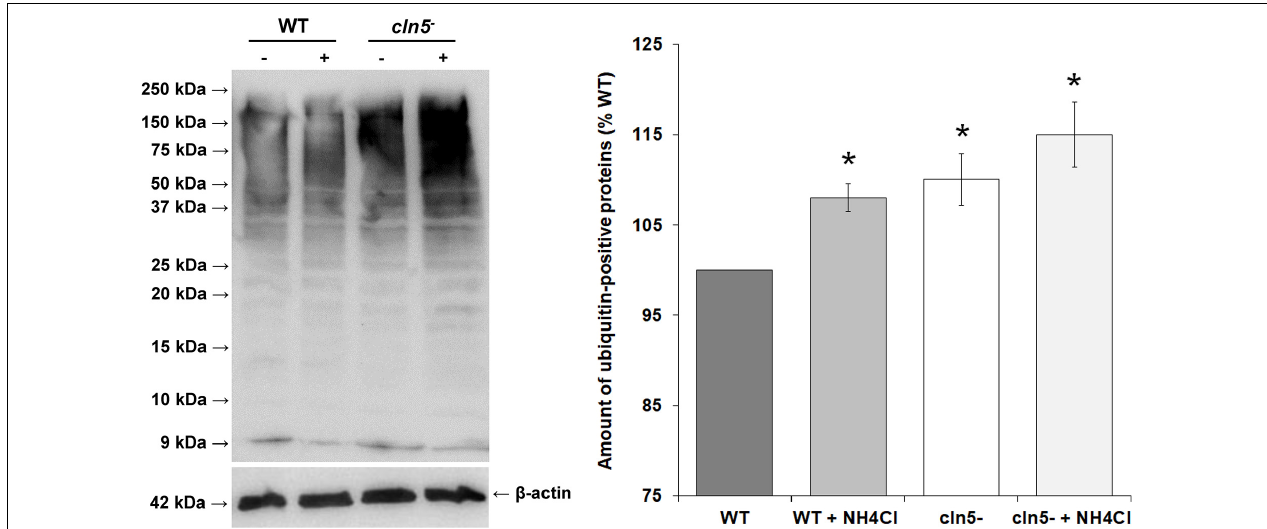
FIGURE 5 | Effect of cln5 -deficiency on the amounts of ubiquitin-positive proteins. WT and cln5 − cells were submerged in HL5 ± ammonium chloride (100 mM) for 2 h. Whole cell lysates (25 µ g) were separated by SDS-PAGE and analyzed by western blotting with anti-ubiquitin and anti-beta-actin (loading control). Molecular weight markers (in kDa) are shown to the left of the blot. The amounts of ubiquitin-positive proteins were quantified, normalized to beta-actin, and plotted. Raw values were then expressed as a percentage of the amounts of ubiquitin-positive proteins in WT cells. Data presented as the mean amounts of ubiquitin-positive proteins (% WT) ± SEM ( n = 3). Statistical significance was assessed using the one-sample t -test. * p -value < 0.05 vs.